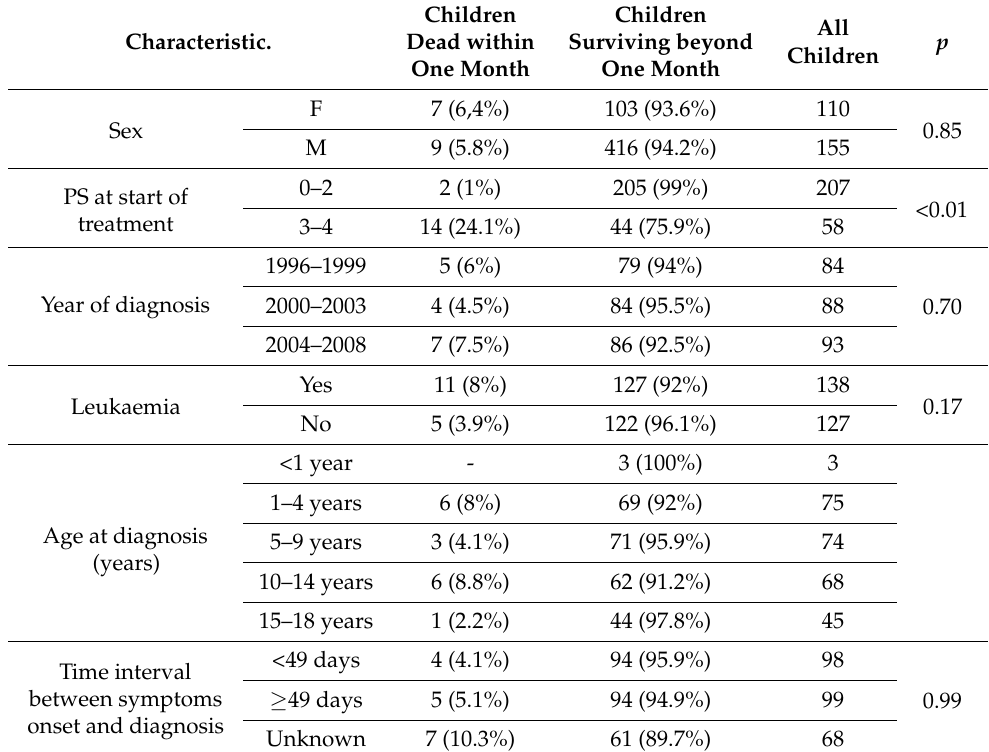
Table 4. Characteristics of patients diagnosed with haematological malignancies.